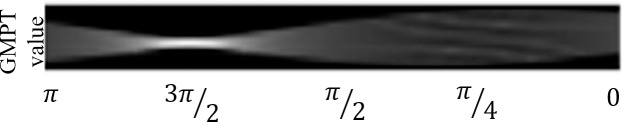
The GMPT result for a straight line of an image contour using Eq (4) in different directions, where θ ∈ [0,π].Lighter regions indicate greater function values and black denotes zero.